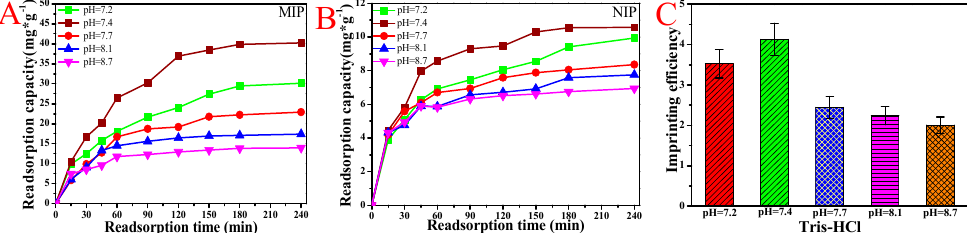
Figure 7. The rebinding curves ( A ) and imprinting efficiency ( C ) of the MIP to BSA after being eluted by Tris-HCl at different pH values; the rebinding curves ( B ) of NIP CaAlg membrane after being eluted by Tris-HCl at different pH values. NaAlg concentration: 2.5 wt.%; pH of BSA solution: 6.2; and copper wire diameter: 0.1 mm.